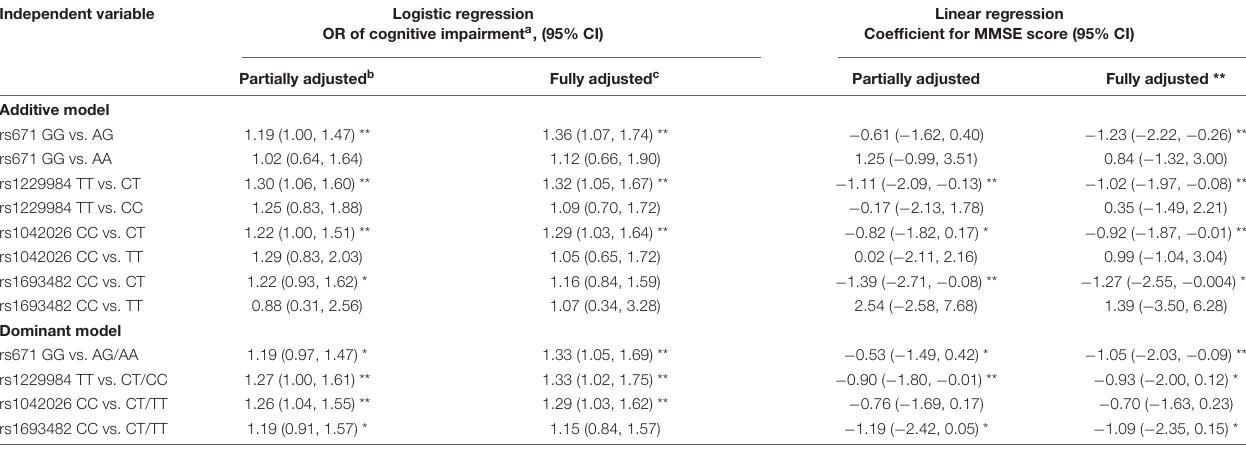
TABLE 2 | Association of ALDH2 rs671, ADH1B rs1229984, ADH1B rs1042026, and ADH1C rs1693482 polymorphisms with cognitive impairment. a